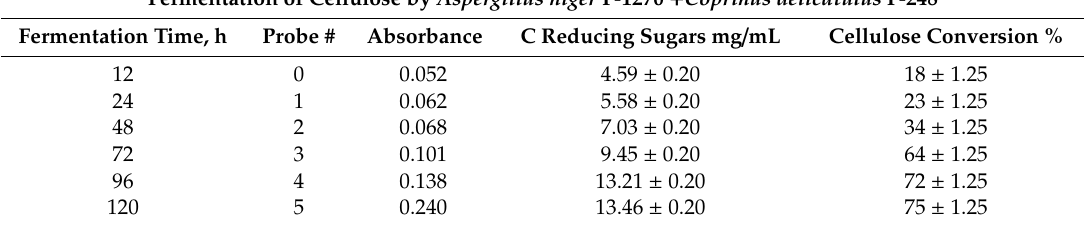
Table 3. Yield of reducing sugars during cellulose fermentation by a yeast consortium of